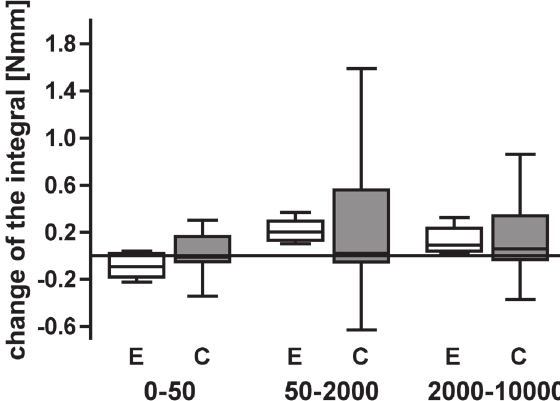
Figure 6- Comparison of the retention force changes of the two groups (E=electroplated female part, C=cast female part). The three phases are shown: start phase (cycle 0-50), initial phase (cycle 50-2,000), wear period (cycle 2,000-10,000)